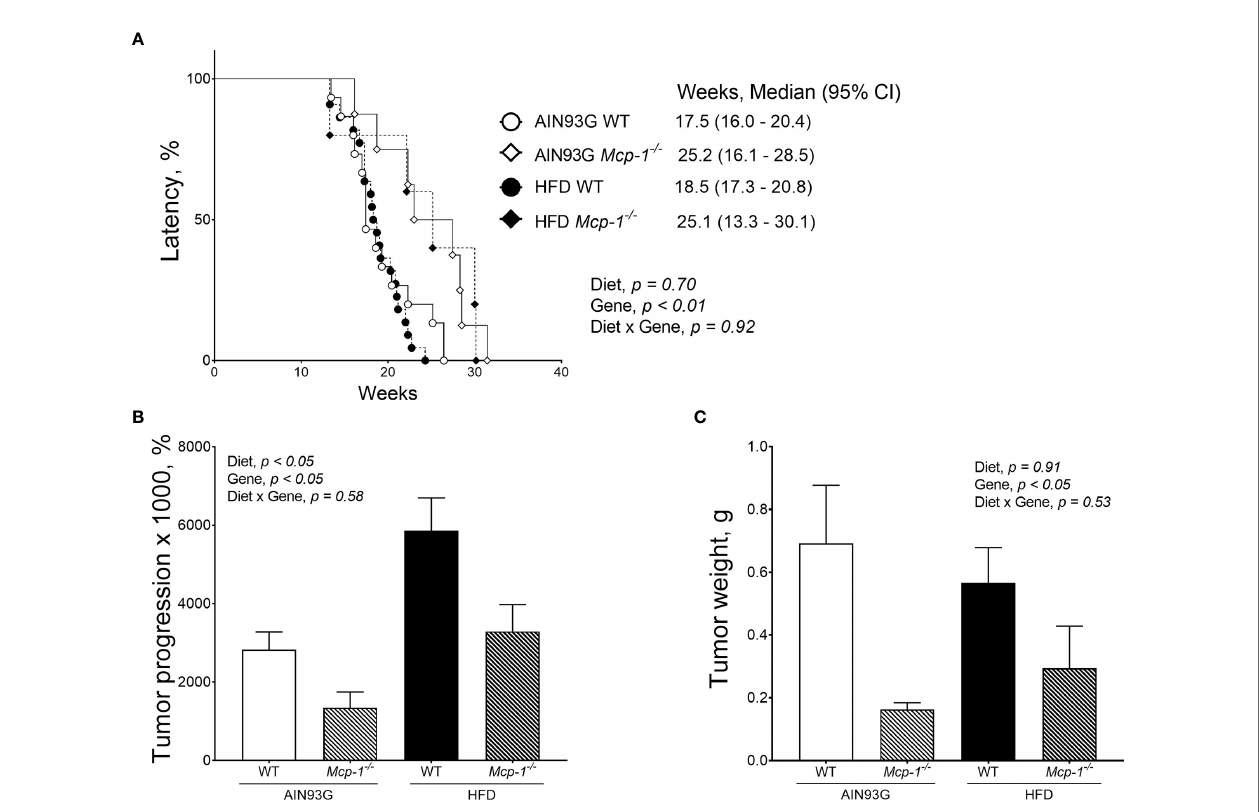
FIGURE 3 | Mammary tumor latency (A) , tumor progression (B) , and tumor weight (C) of MMTV-PyMT mice with or without adipose monocyte chemotactic protein-1 knockout [ Mcp-1 -/- or wild-type (WT)] and fed the AIN93G or high-fat diet (HFD). Values are means ± SEM [(n = 5-22 per group) for (B, C) ]. N = 32-34 per group for (A)